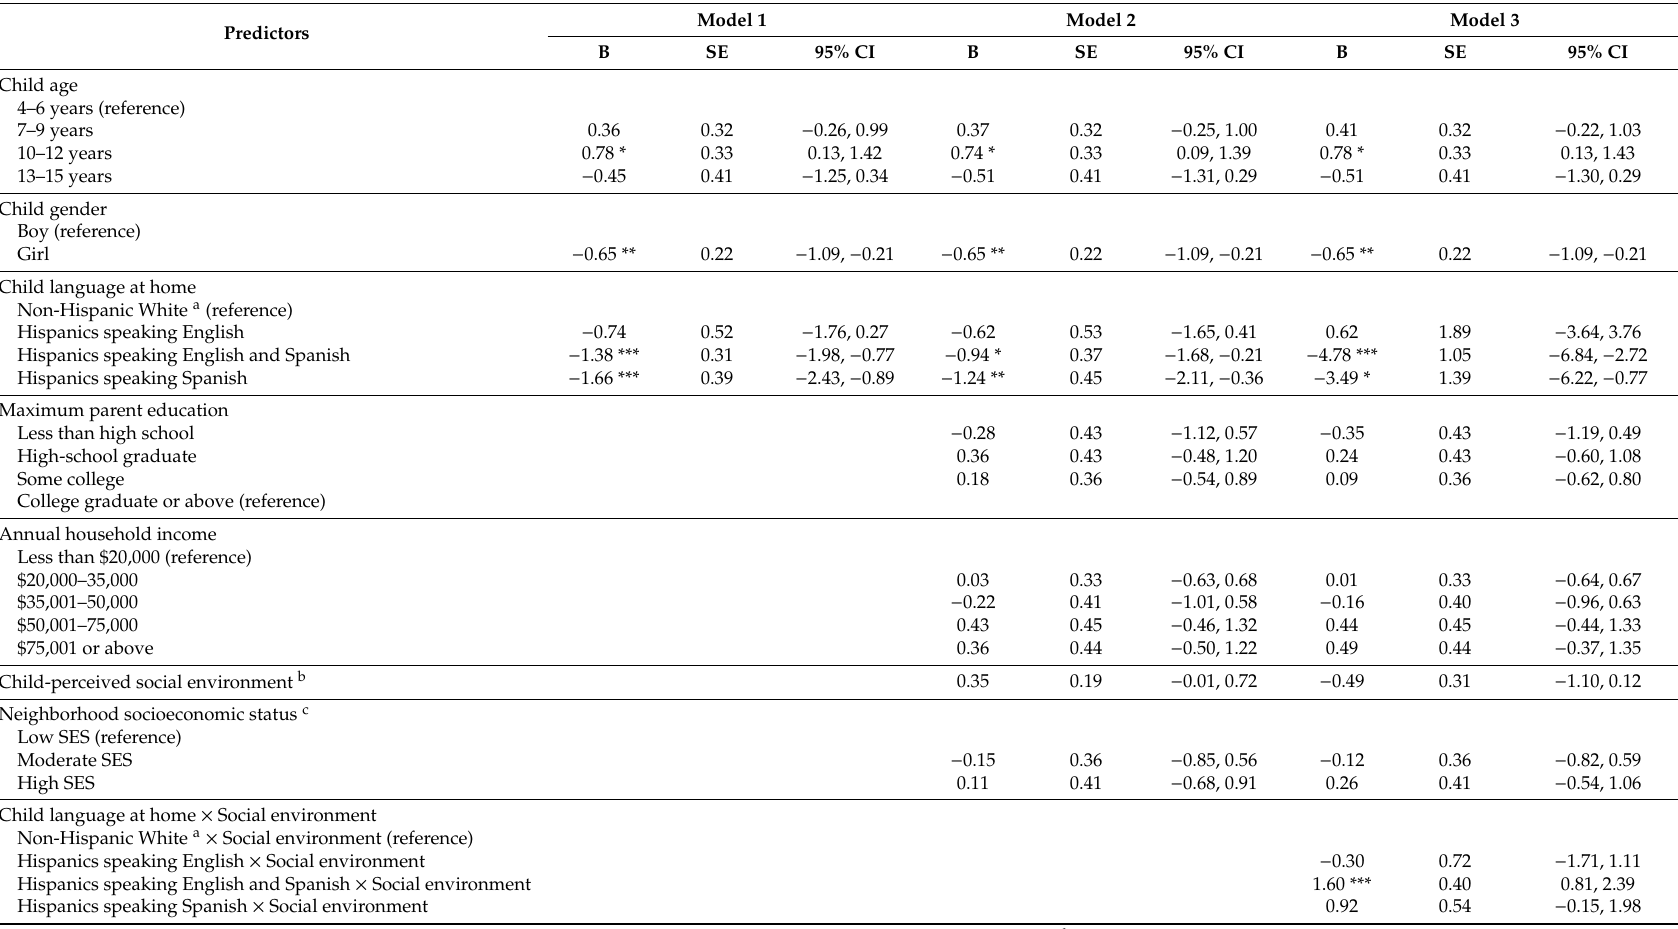
Table 3. Results of multilevel modeling assessing associations between child language at home and physical activity (times per week), n =